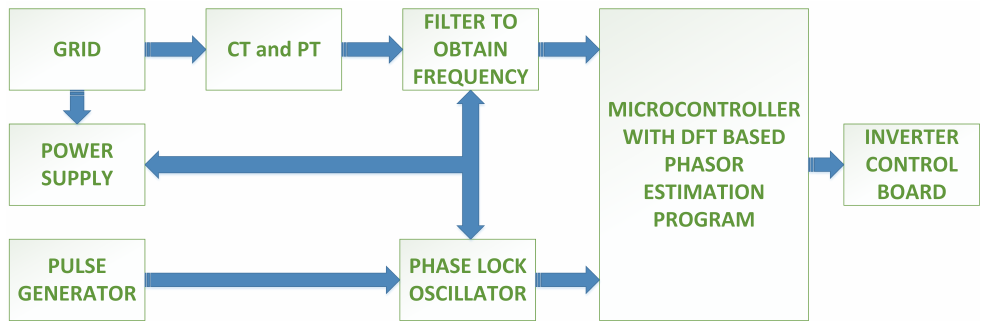
Figure 4. Block diagram representation of the process to obtain real-time phase angle values from grid. The following operations are performed by the SMX/SMG